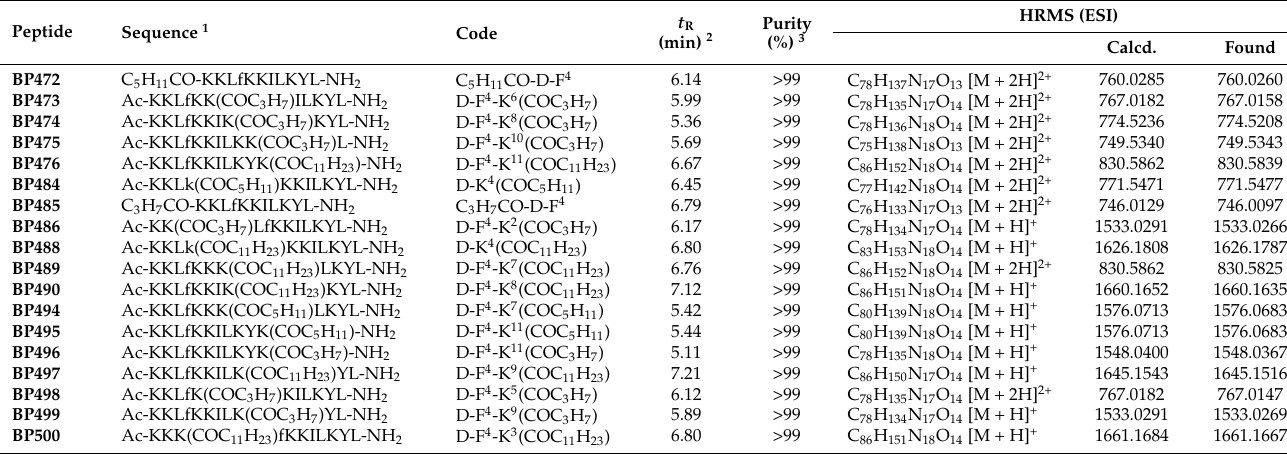
Table 1. Sequences, retention times and purities on HPLC, and mass spectrometry data of lipopeptides.